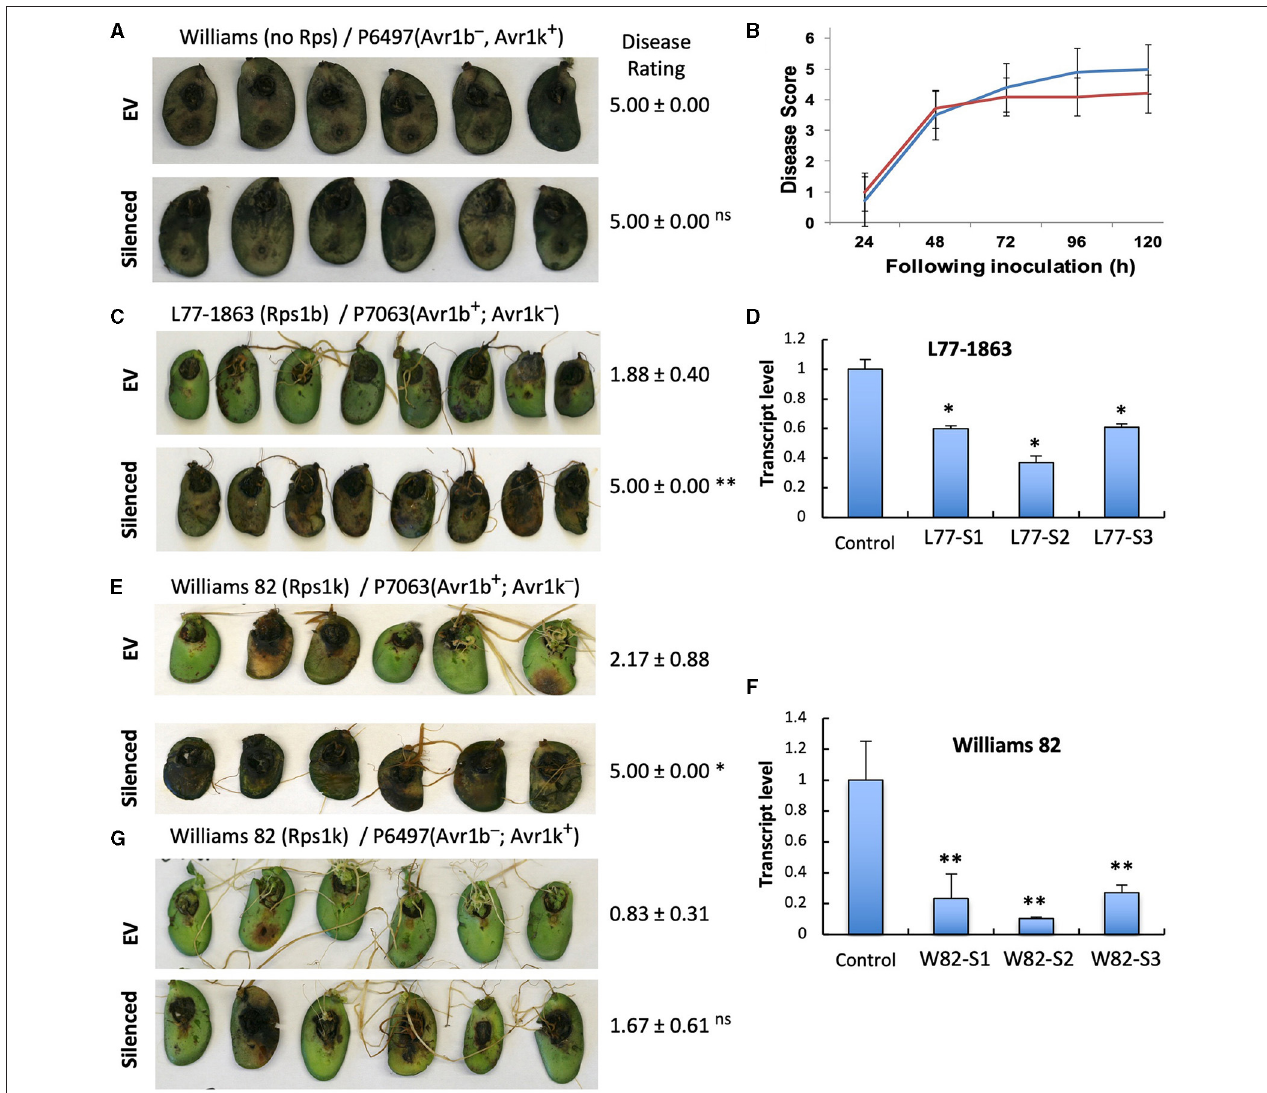
FIGURE 4 | Silencing of GmPUB1 genes resulted in specific loss of Avr1b recognition by products of the Rps1 -b and Rps1 -k loci. (A,C,E,G) Soybean cotyledons carrying Rps1 -b (C) , Rps1 -k (E,G) , or no Rps gene (A) were inoculated with A. rhizogenes harboring the GmPUB1-1 :RNAi vector or pART27GFP empty vector. Six days later, the cotyledons were inoculated with mycelia of P. sojae strains P6497 (A,G) or P7063 (C,E) . Cotyledons were photographed 3 days after P. sojae inoculation and the disease rating scored as described in the Methods. True disease lesions showed diffuse brown margins. HR lesions were smaller and showed sharp black margins. Disease rating means and standard errors are shown. Significance of the differences between empty vector (EV) and silenced cotyledons were determined by the Wilcoxon Rank Sum Test; * p < 0.05, ** p < 0.01, ns = not significant p > 0.05. GmPUB1-1 and GmPUB1-2 sequences are near-identical and expected to be co-silenced. (B) Disease development over time following inoculation with P. sojae CC5C. Means and standard errors were calculated from 20 infected cotyledons. Red line represents the GmPUB1 silenced cotyledons and blue line represents the empty vector transformed cotyledons. (D,F) Transcript levels of GmPUB1 ( GmPUB1-1 and GmPUB1-2 combined) were measured by qRT-PCR in three individual soybean cotyledons of L77-1863 (D) or Williams 82 (F) inoculated with A. rhizogenes harboring the GmPUB1-1 :RNAi vector. Error bars represent standard errors from three technical replicates. * and ** indicate p < 0.01 and 0.001, respectively, for the difference with the